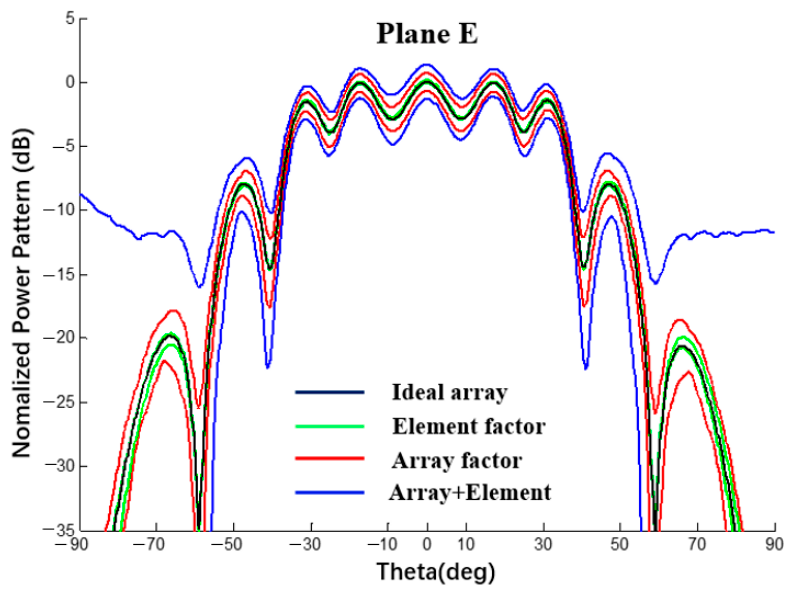
Figure 26. Interval power pattern based on the error of different factors of 10 × 10 arrays (uniform excitation). Table 7. SLL interval value in Figure 25 (1 × 10 linear array).